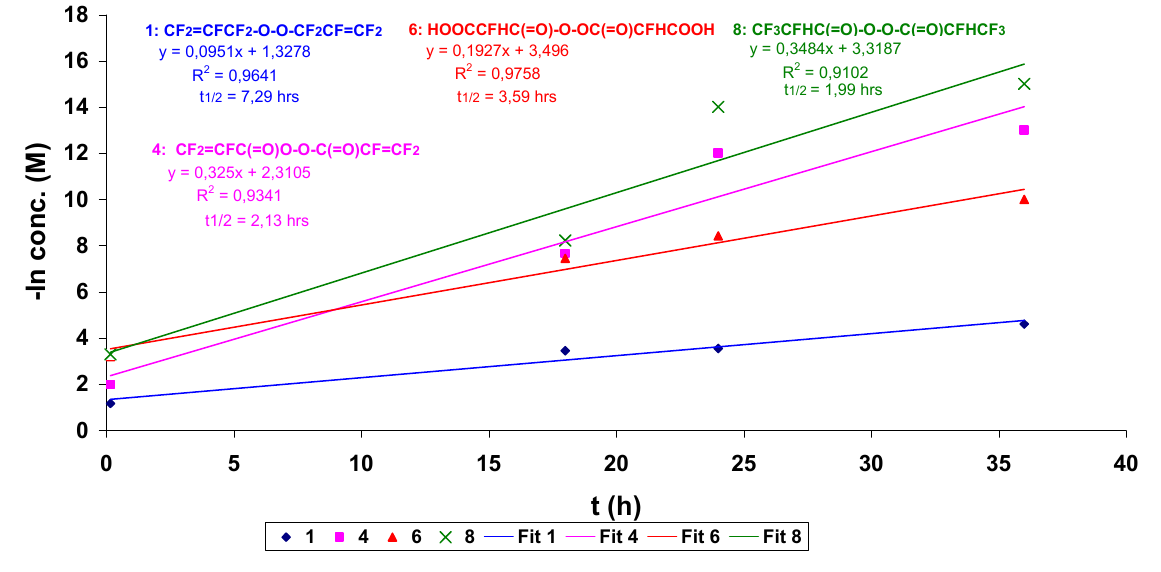
thermal decomposition rate constant k